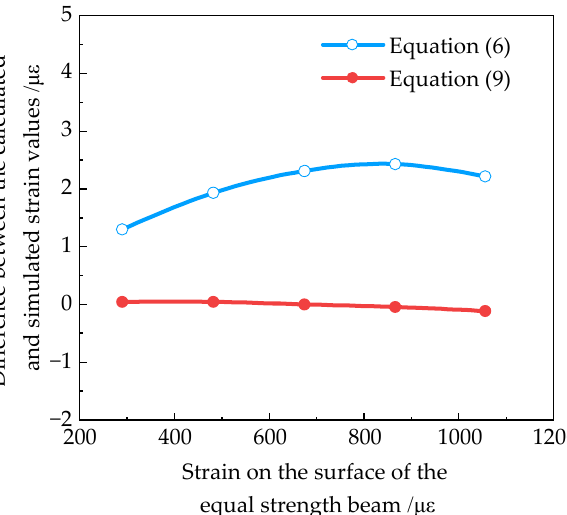
Figure 5. Difference between calculated and simulated values of Equations (6) and (9).